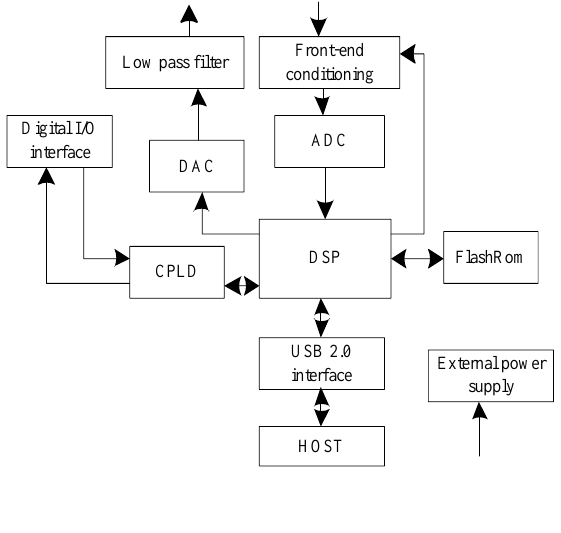
Figure 2. Diagram of data acquisition module